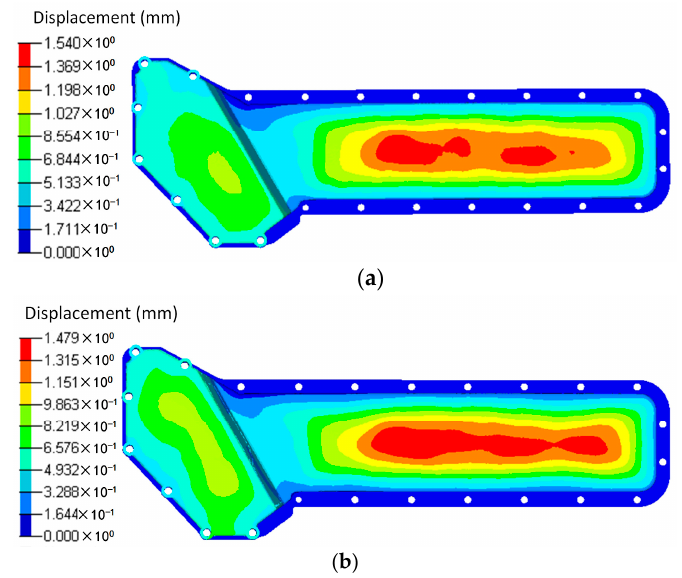
Figure 15. Displacements of ( a ) the isotropic and ( b ) the orthotropic oil cooler covers under distributed temperature difference.